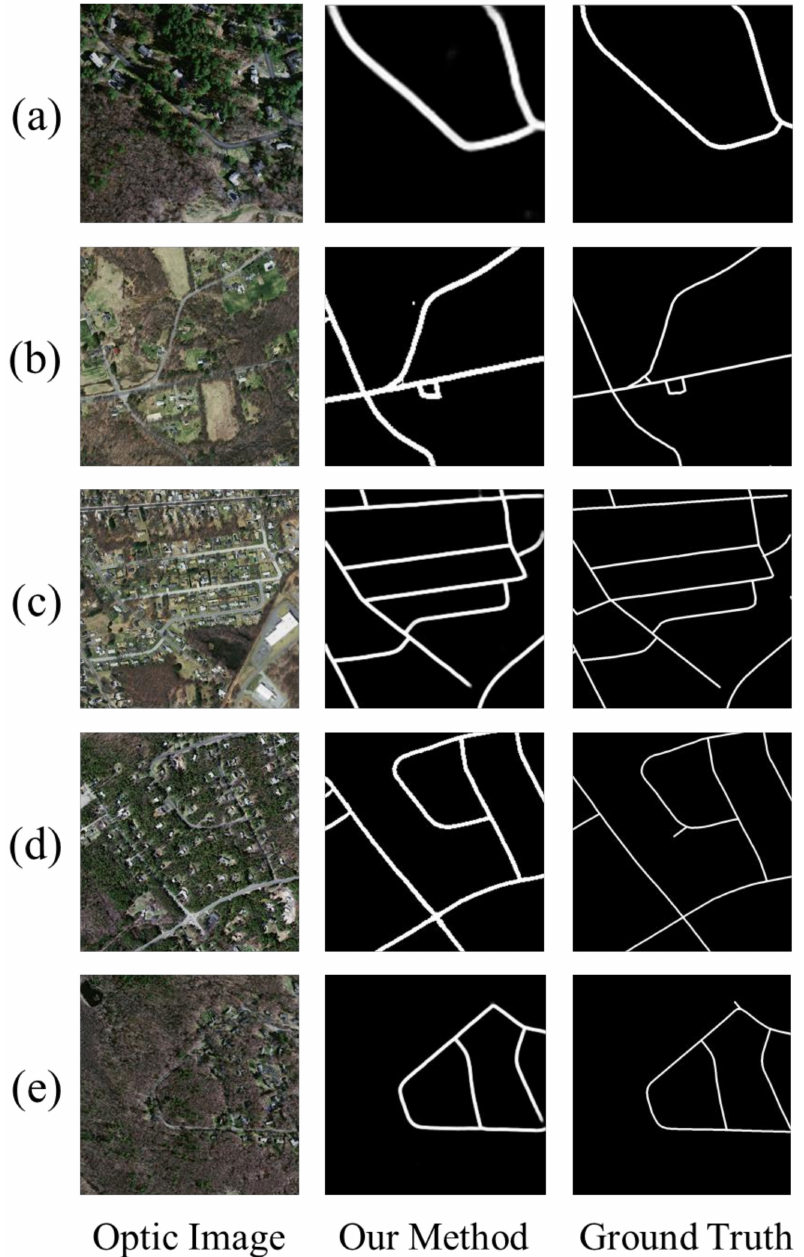
Figure 5. Visualization results of the road area occluded by trees: Each row in ( a – e ) contains an RGB image, a segmentation result map of the proposed method, and a ground truth map of a sample